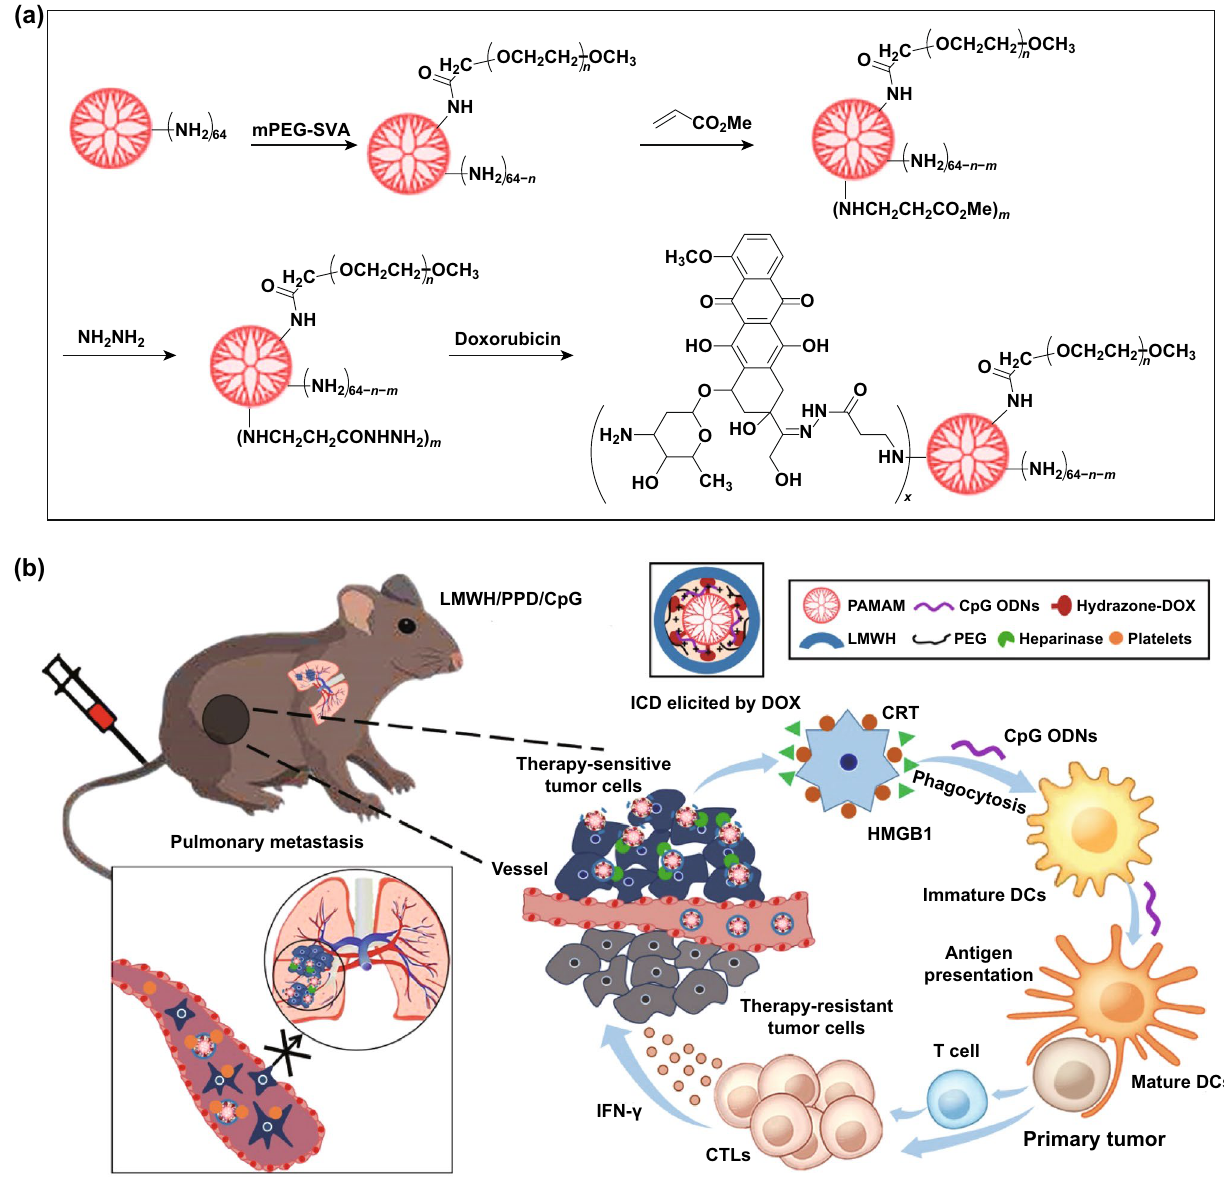
Fig. 5 a Schematic illustration of reaction scheme for the synthesis of pH-sensitive hydrazone bond linked PEG-PAMAM-DOX conjugates (PPD). b Schematic illustration of LMWH/PPD/CpG to inhibit melanoma tumor. Reproduced with permission from Ref. [110]. Copyright